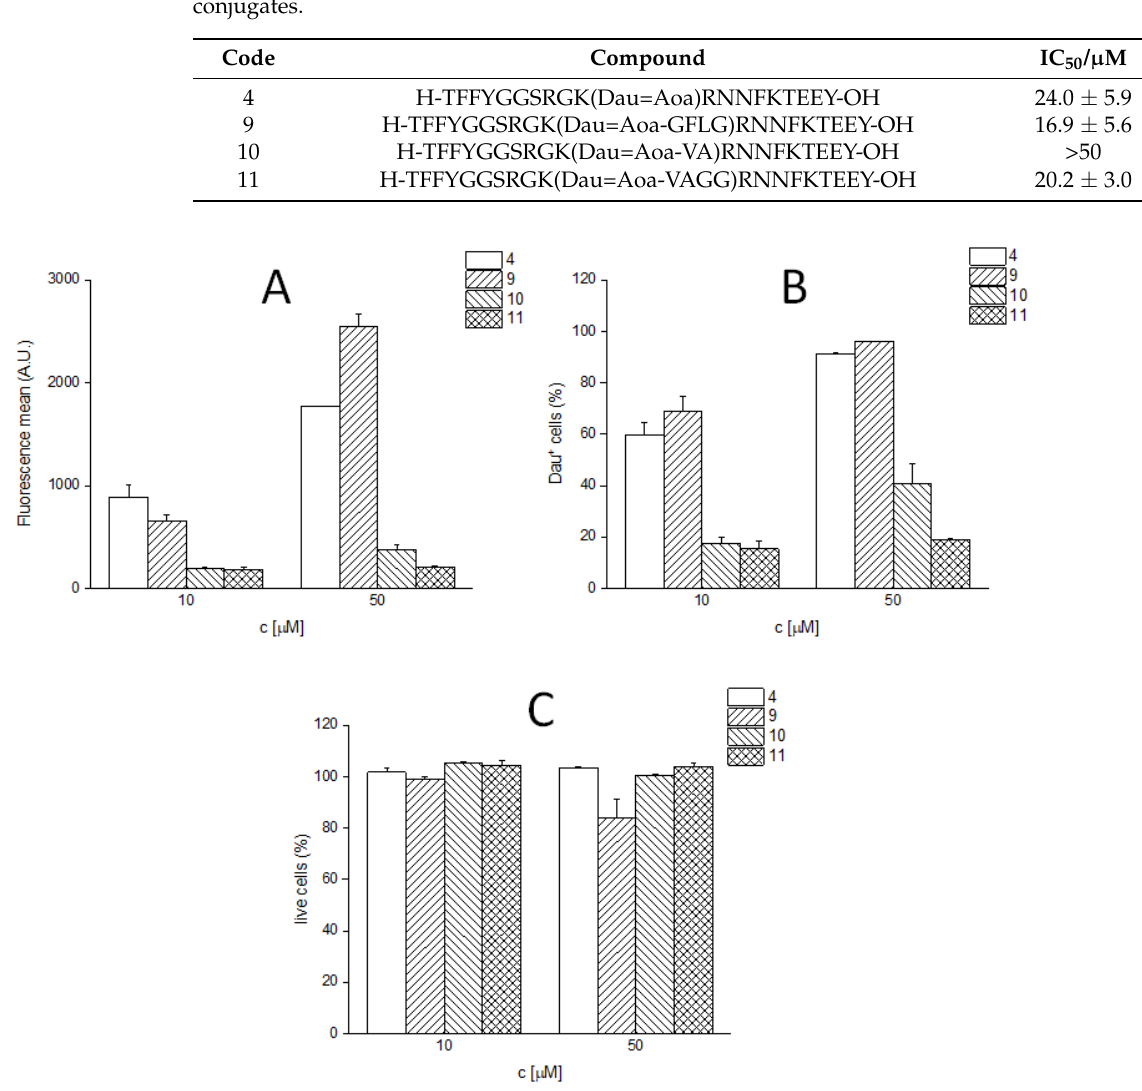
Figure 4. In vitro cellular uptake of the enzyme-labile spacer containing Angiopep-2–daunomycin conjugates. ( A ) Fluorescence mean; ( B ) percentage of Dau-positive live cells (cells showing fluores- cence intensities above the highest fluorescence intensity value of the untreated control cells were considered as Dau+); ( C ): live cells in the percentage of untreated control.